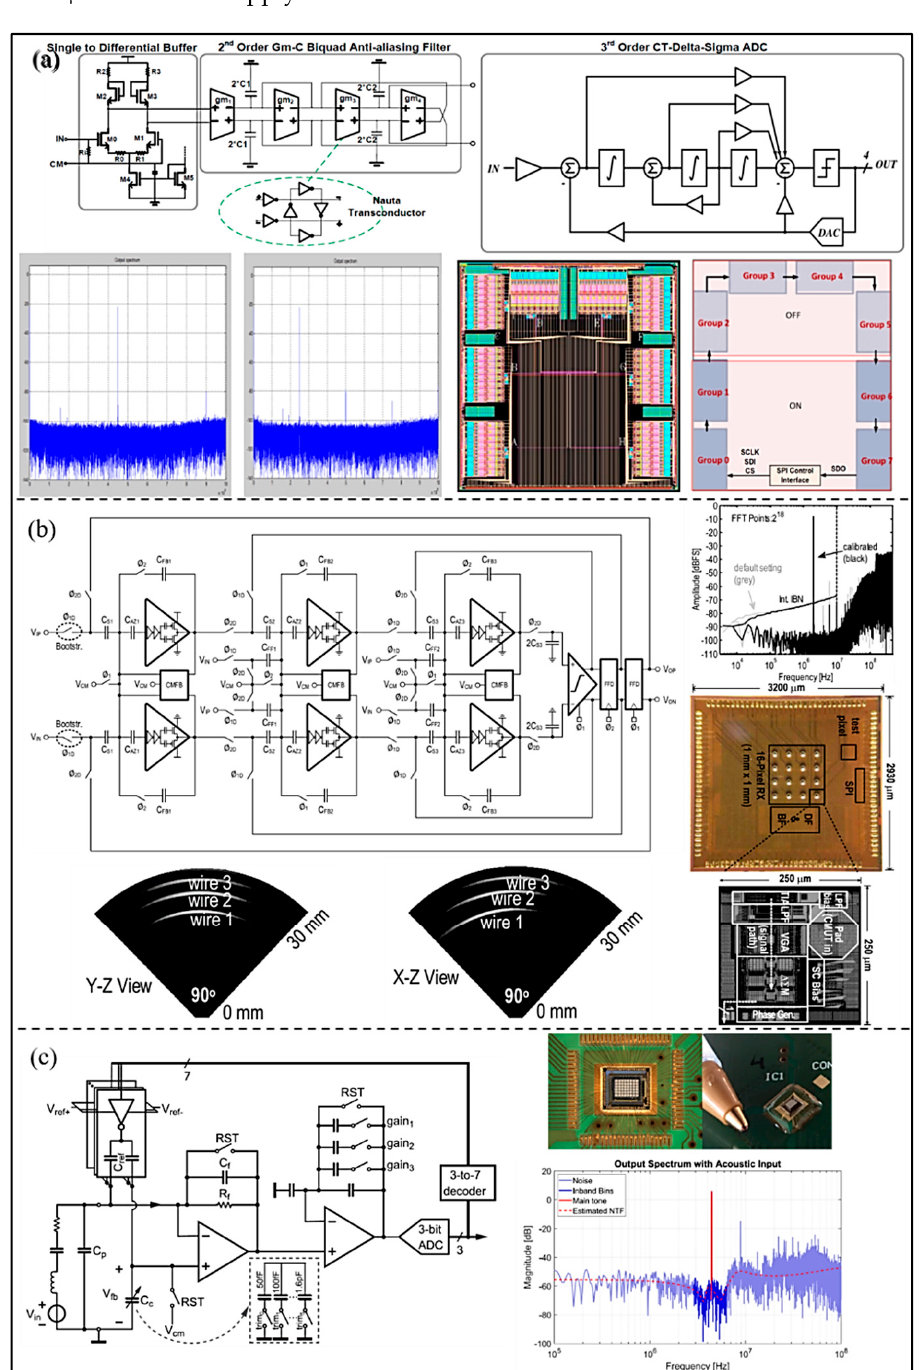
Figure 11. ( a ) IC architecture, layout, and measured results of the ADC in the design.